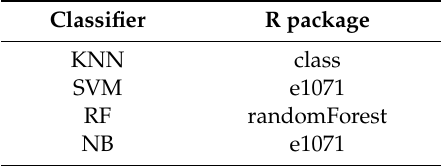
Table 2. Classifiers and their corresponding R